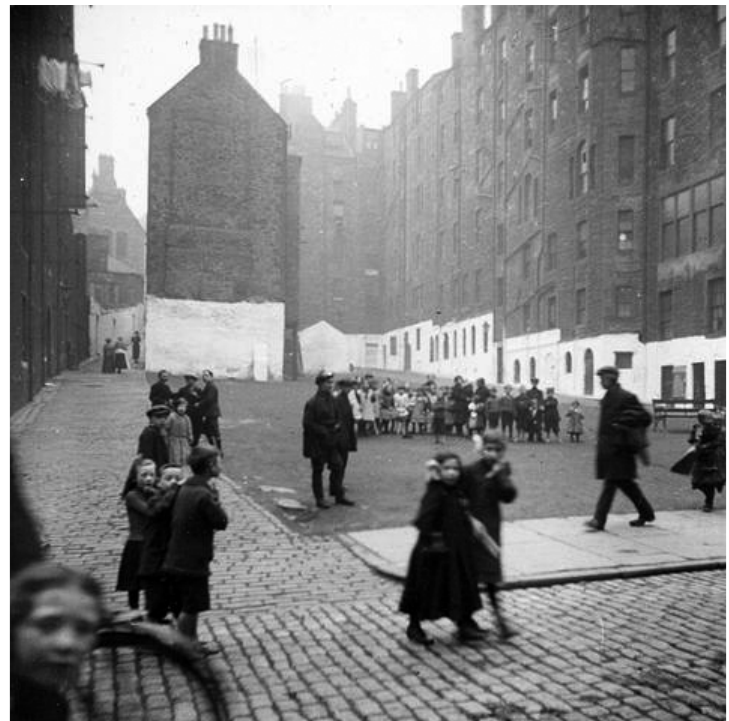
Figure 1. Edinburgh Old Town Tenements, 1911, by Patrick Geddes. Source: Patrick Geddes Papers (n.d.). The natural eugenic center is in every home; its young go out to make new homes; these make the village, the town, the city small or great….Federate homes into co-operative and helpful